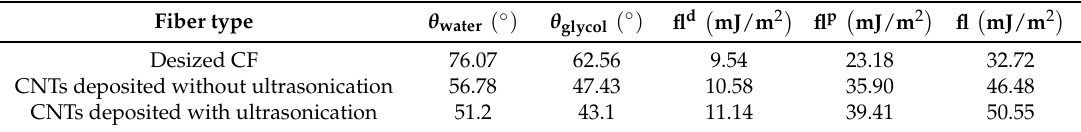
Table 1. Contact angles and surface free energy.